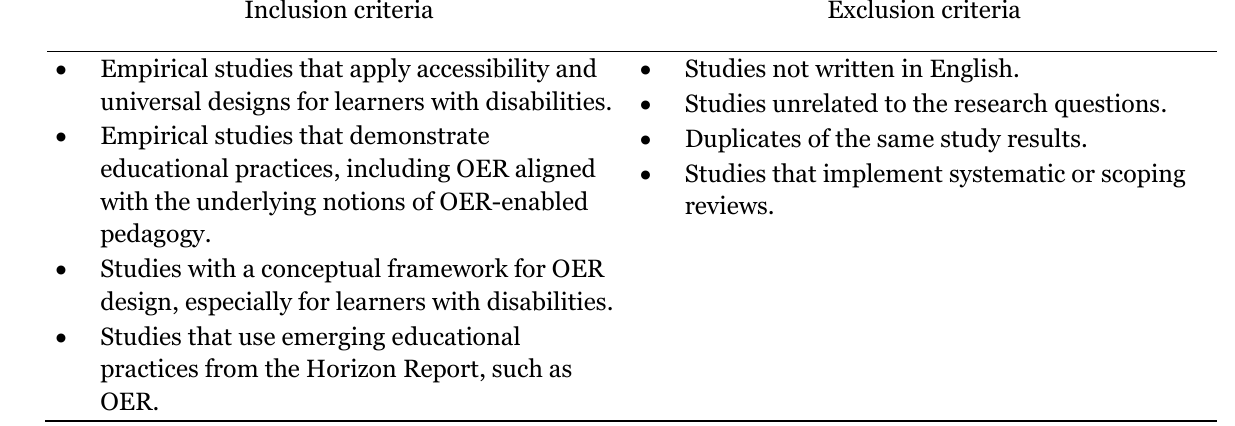
Inclusion and Exclusion Criteria for Data Collection Inclusion criteria Exclusion